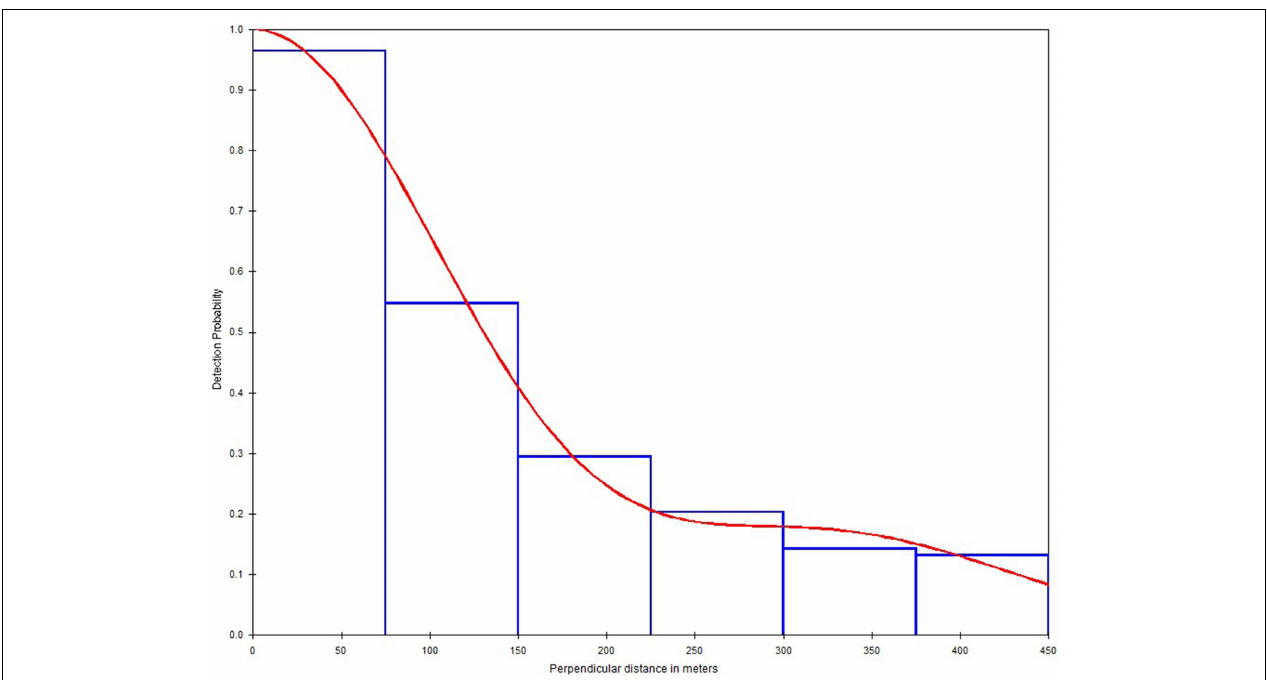
FIGURE 3 | Detection functions fitted to the perpendicular distances of observations of groups of Irrawaddy dolphins. On-effort sightings were pooled across survey strata and survey years. Data were grouped for final analysis using six equal-spaced intervals with right truncation at